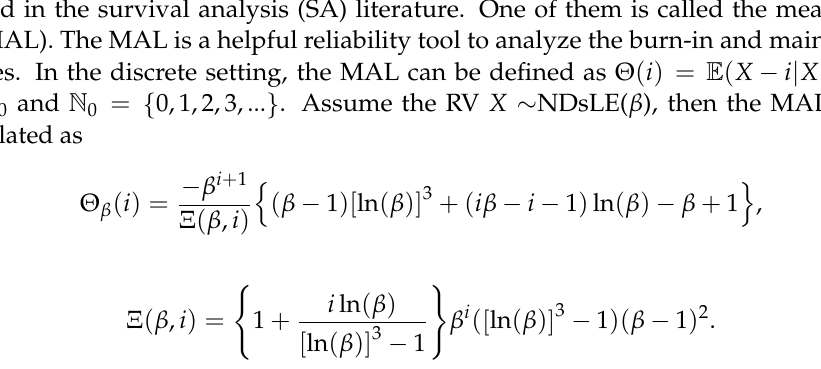
Figure 2. Some DS plots for the NDsLE model.